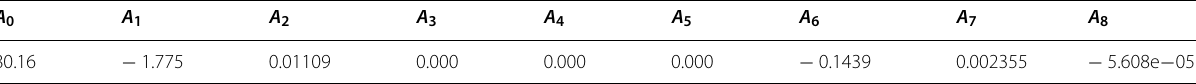
Table 4 Resultant coefficients of the low-risk-level weighted risk curve for specific ages, fitted to Eq. 14 A 0